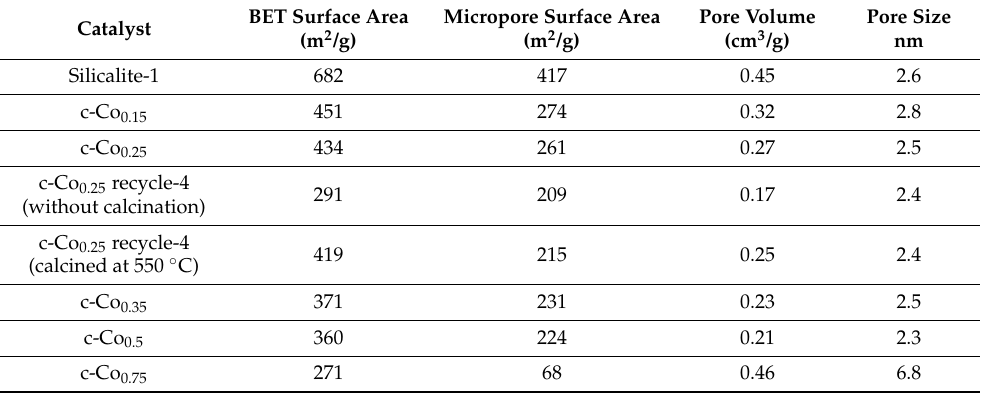
Table 1. Textural properties of silicalite-1 and c-Co x.